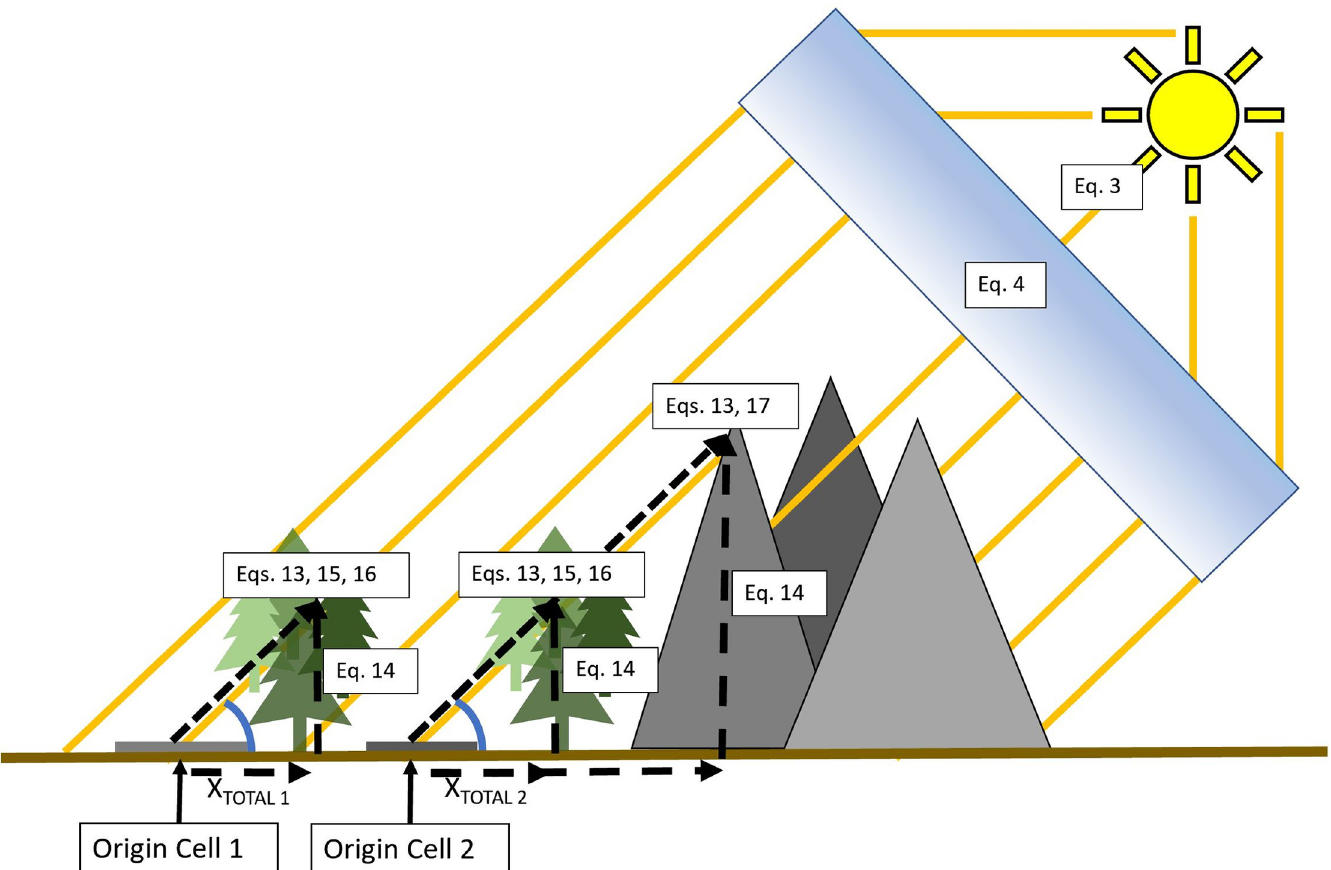
Fig 2. Spatially tracking of solar ray for the x and y , and x and z dimensions. Penumbra’s solar ray approach to shade modeling for both object and topographic shadowing. Equation numbers correspond to equations described under Processing